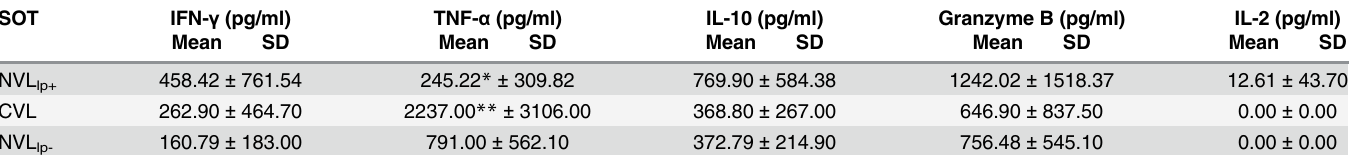
Table 2. Cytokine and granzyme B production in whole blood plasma in response to PHAM stimulation for 24 h. The IFN- γ , granzyme B, TNF- α , IL- 10 and IL-2 concentrations (pg/ml) were measured for 12 NVL lp+ subjects, 7 NVL lp- subjects, and 5 CVL subjects.